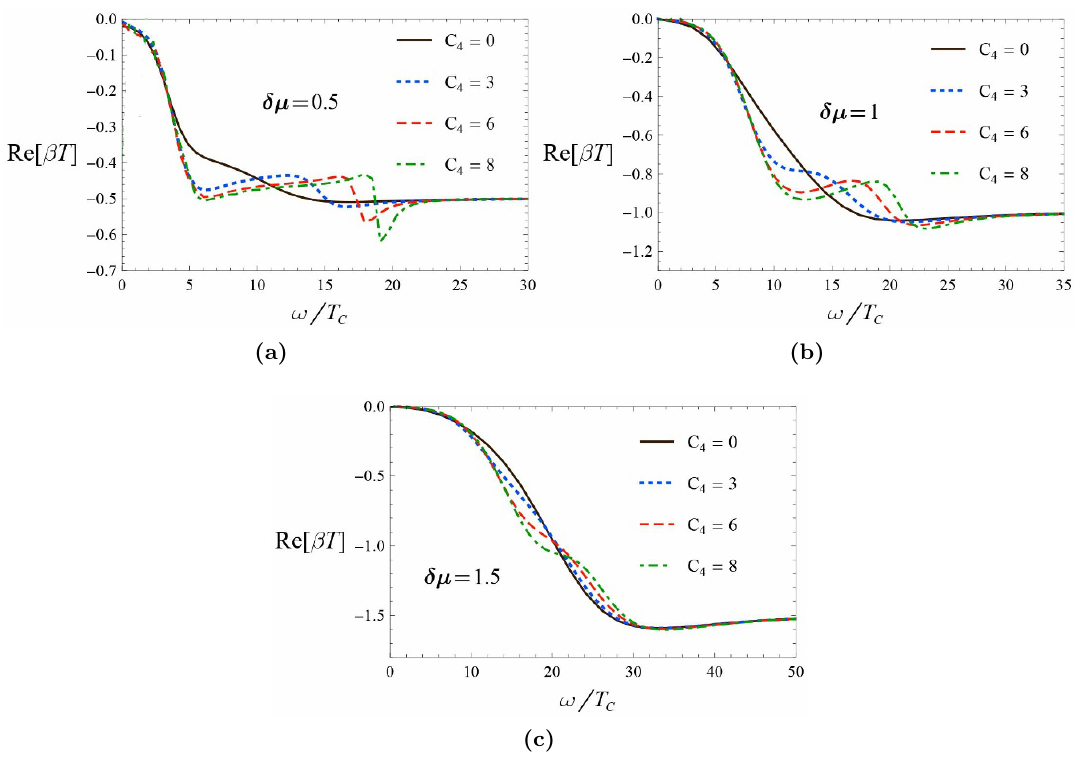
Figure 15. The real part of the thermo-spin conductivity in terms of !=T c for function F ( ) = 2 + C 4 with C 4 4 = 0 ; 3 ; 6 ; 8 (solid curve, dotted curve, dashed curve, and dot-dashed curve)